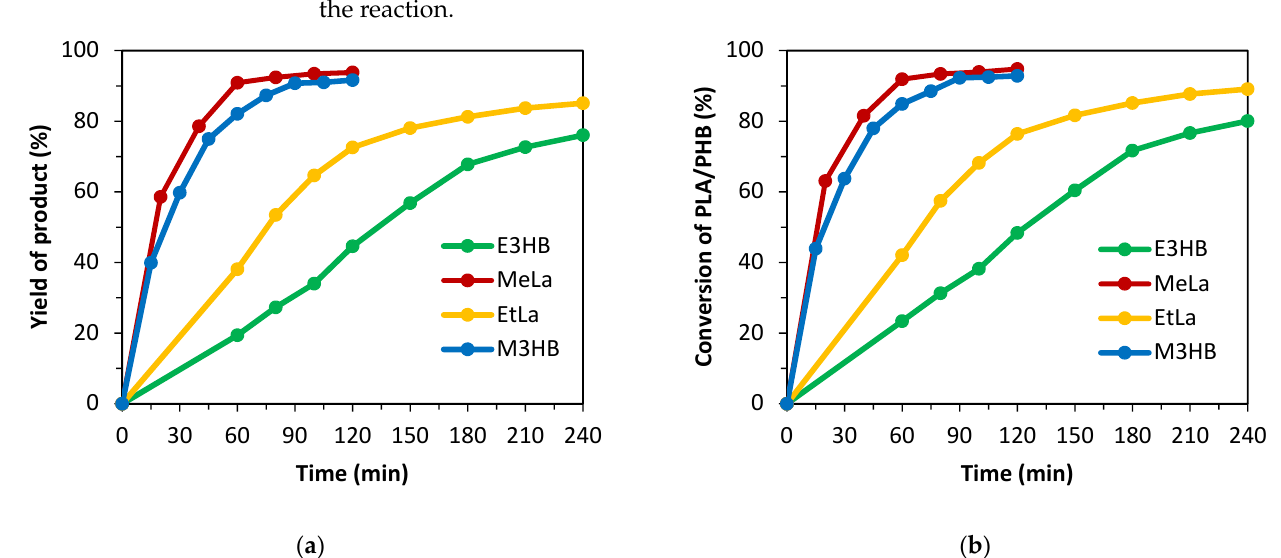
Figure 1. ( a ) The increase in particular yields of monoesters during the depolymerization reaction of PLA or PHB; ( b ) the increase in particular conversions of polymers during the depolymerization reaction of PLA or PHB.